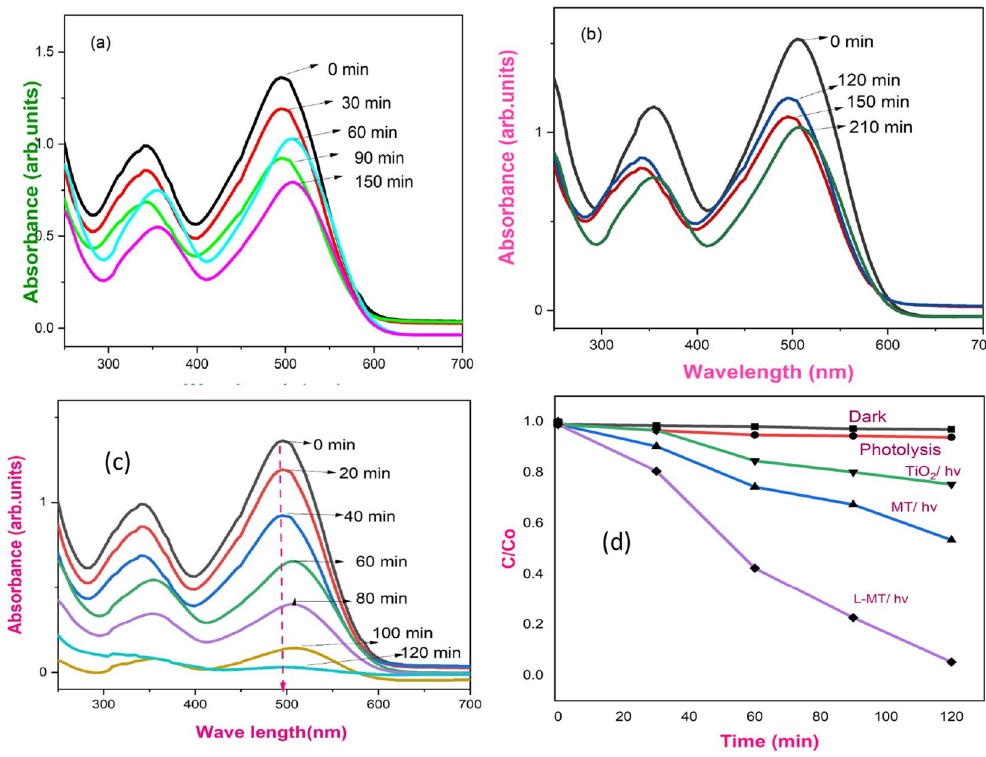
Figure 5. UV–Visible absorption spectra of CR dye with PT ( a ). MT ( b ). L-MT ( c ) (Reaction conditions: dye concentration 15 mg/L, pH3/60 mg cat); C/Co vs irradiation time ( d